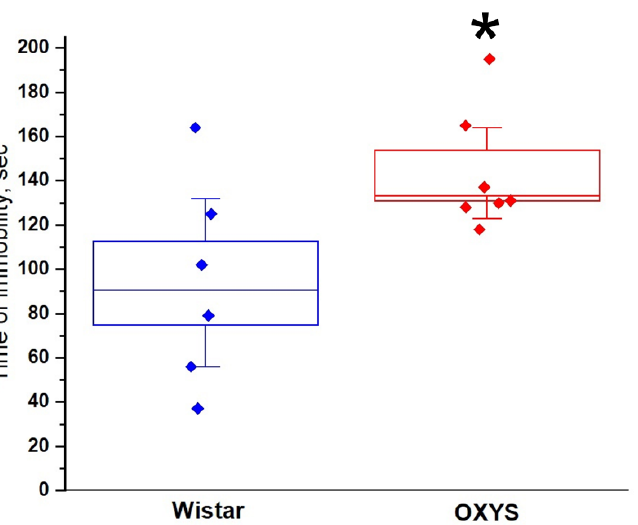
Figure 8. Duration of immobility in the forced swim test. * p < 0.05 as compared to control (Wistar) rats. The data are presented as the mean ± SEM. rats. The data are presented as the mean ±